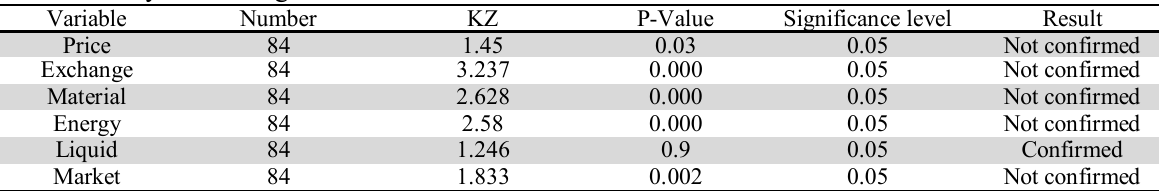
The summary of Kolmogorov-Smirnov test